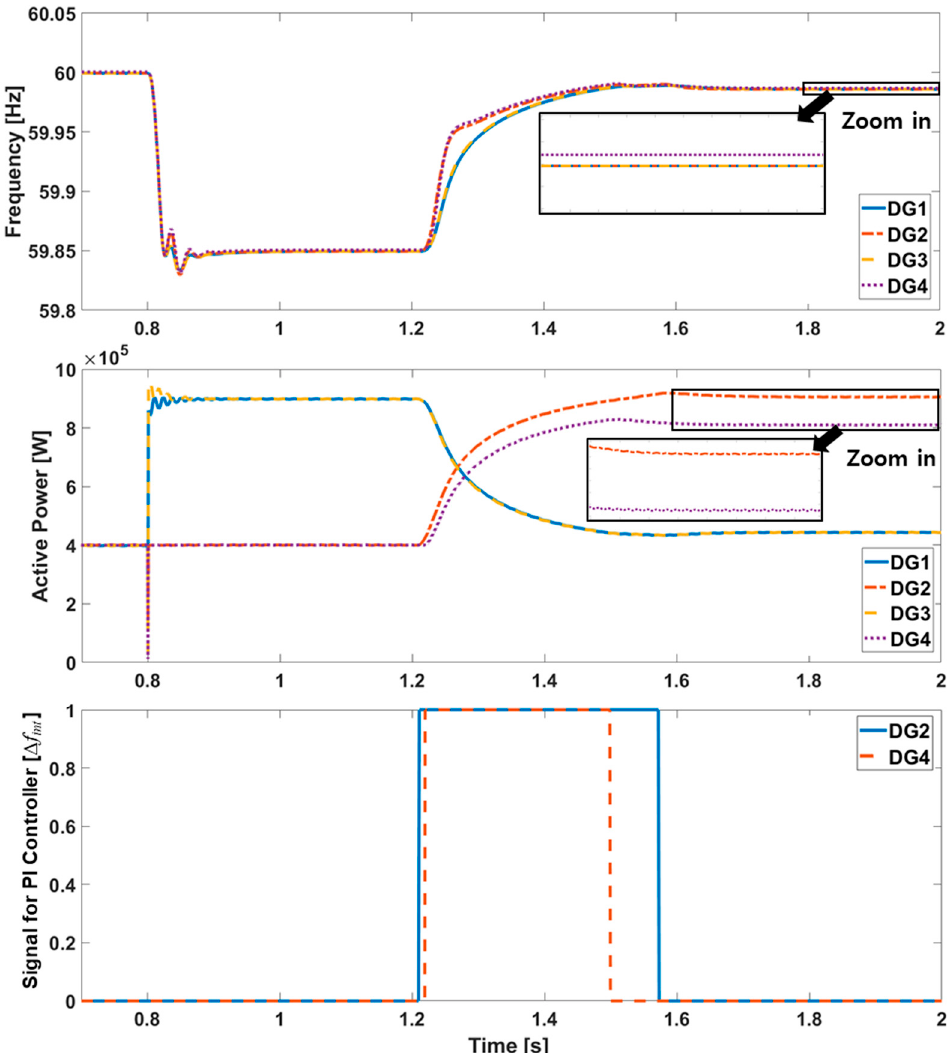
Figure 6. Frequency restoration results obtained using the proposed controller.